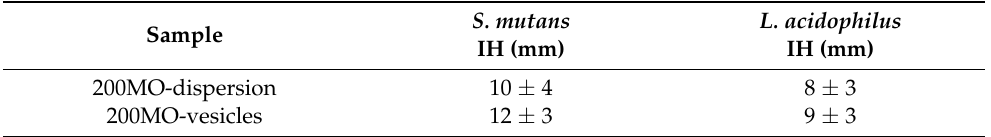
Table 4. Inhibition halo (IH) of quercetin and peppermint oil (200 mg/mL) in dispersion and vesicles loaded quercetin and mint oil (200 mg/mL) against S. mutans and L. acidophilus . Mean values ± standard deviations are